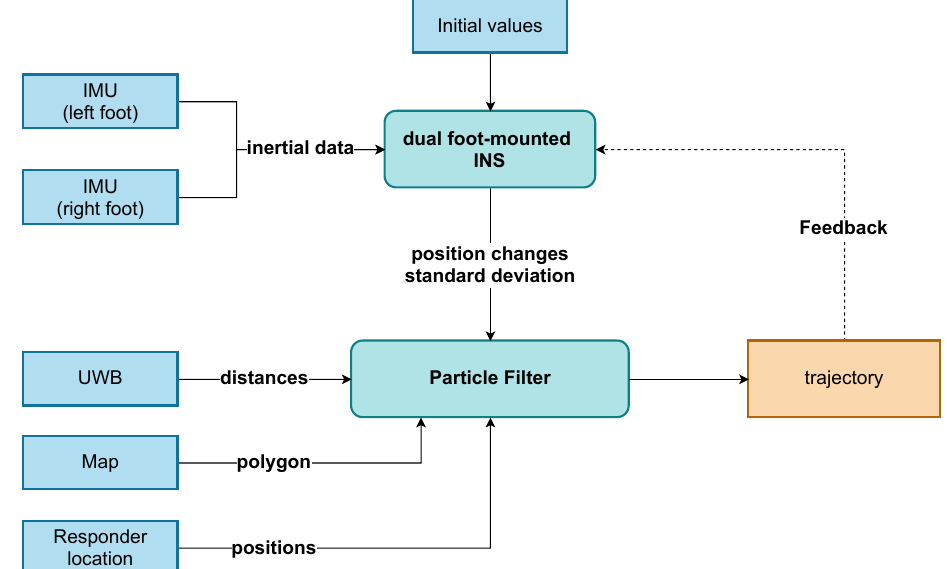
Figure 5. Proposed filter